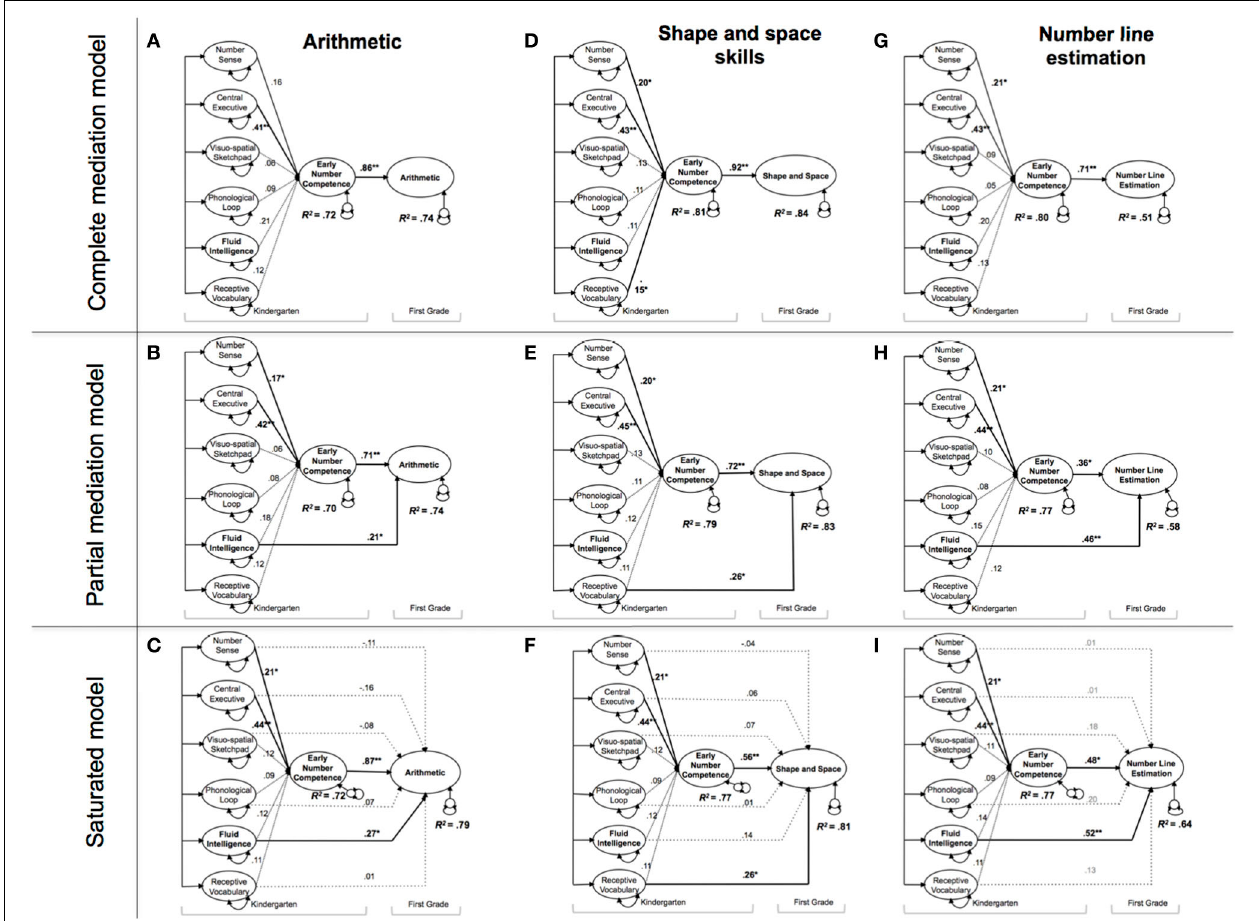
FIGURE 2 | The contributions of number-specific and domain-general abilities on first grade mathematics outcomes. Nine mediation models to study how cognitive predictors measured at kindergarten influence math outcomes in first grade via early number competence. N = 165.